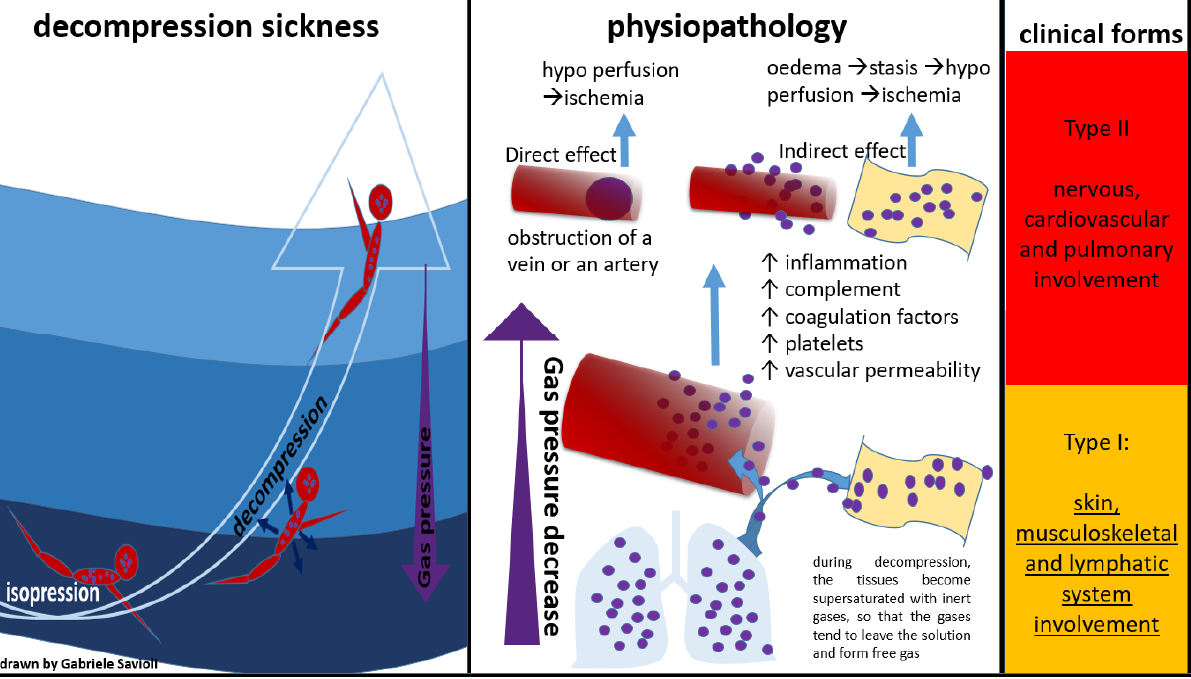
Figure 2. Physiopathology of decompression sickness.